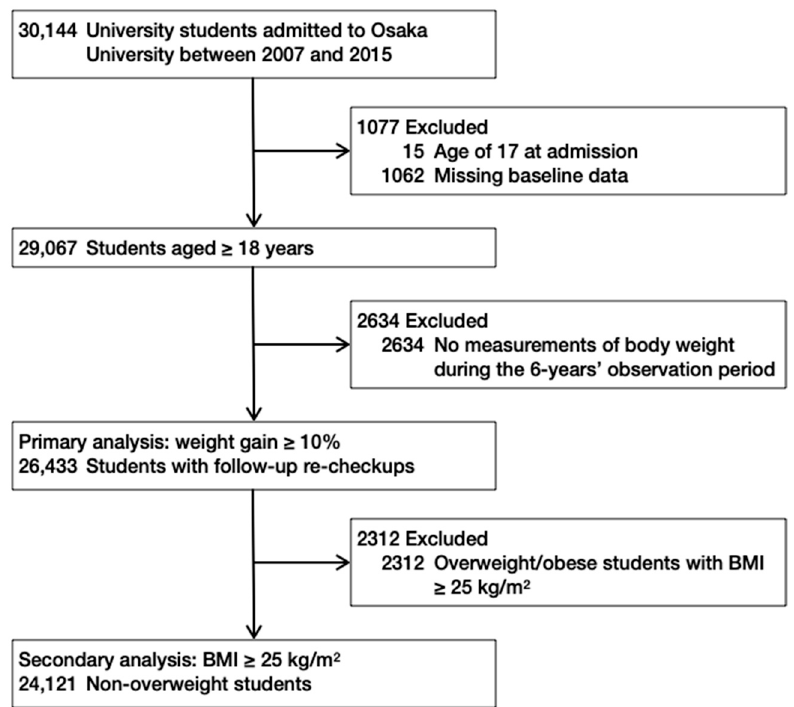
Figure 1. Flow diagram of inclusion and exclusion of study participants. BMI, body mass index.